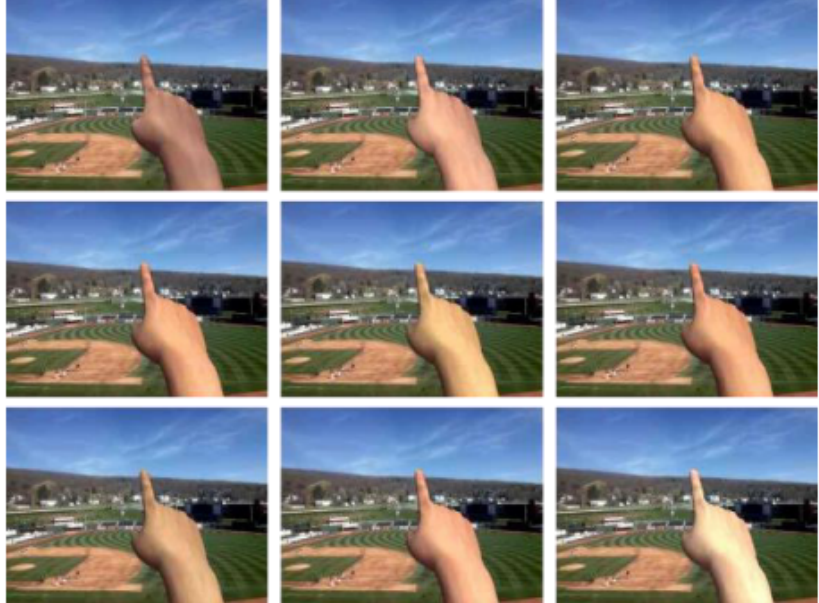
Figure 7. Employing different skin colors and textures to increase diversity of synthetic hands.